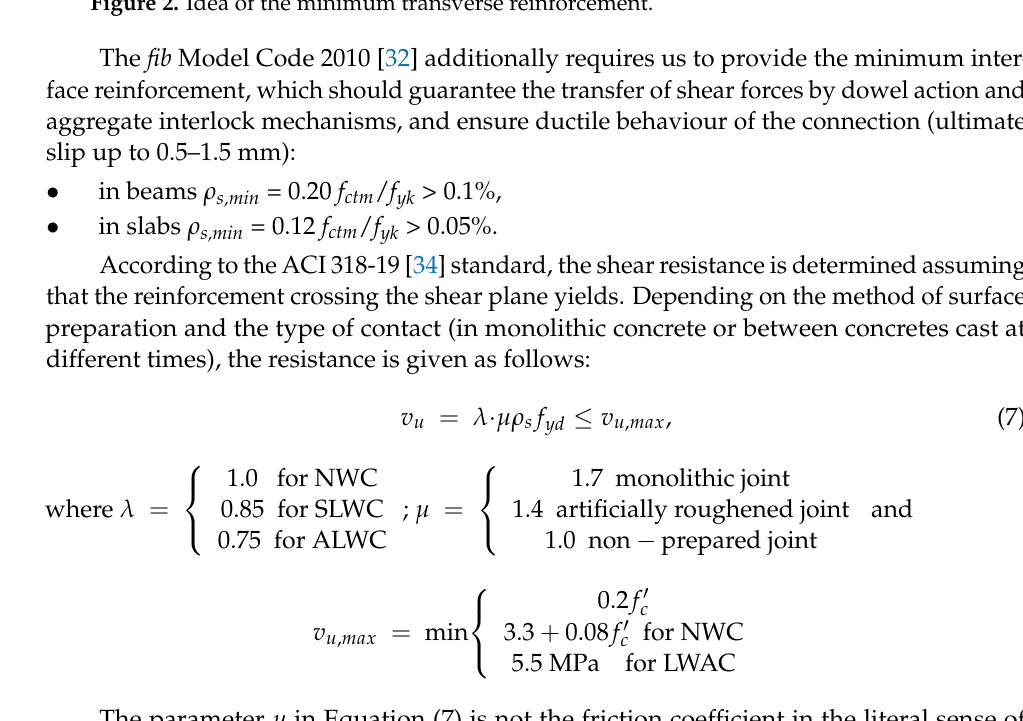
Figure 2. Idea of the minimum transverse reinforcement.